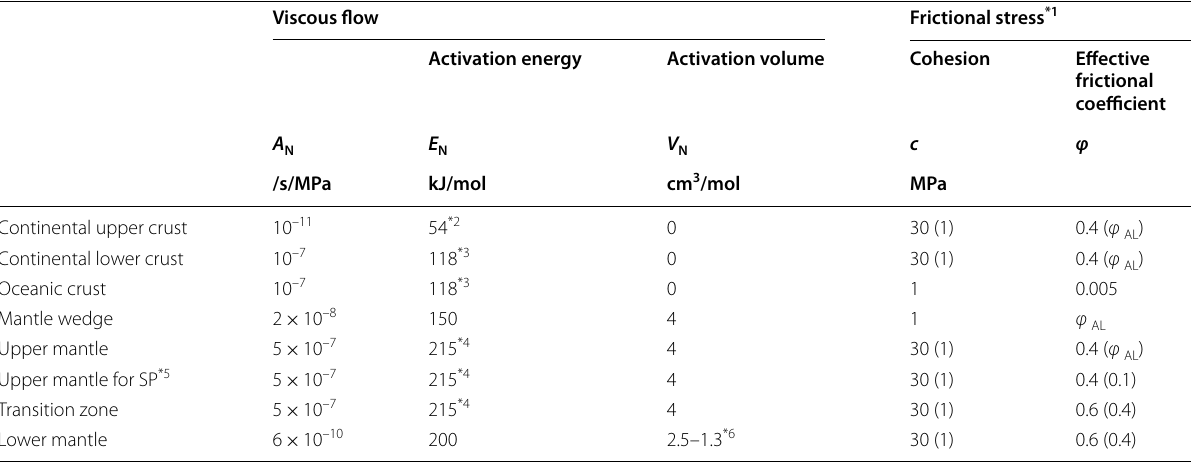
Table 2 Rheological parameters of